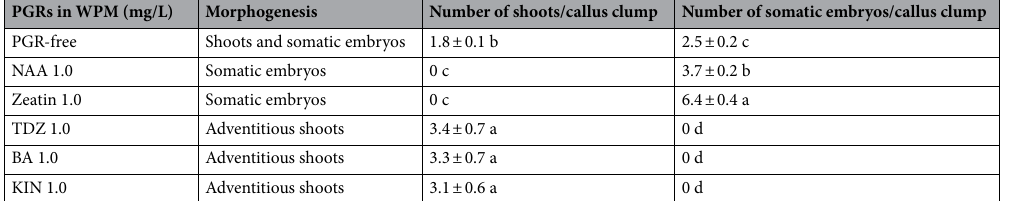
Table 2. Differentiation into shoots and somatic embryos of callus induced by 1.0 mg/L 2,4-D for 6 weeks and then transferred to the different media for differentiation in Euryodendron excelsum . *Each treatment had 30 callus clumps. Values represent means ± SD. Different letters within a column indicate significant differences according to Duncan’s multiple range test ( P ≤ 0.05).